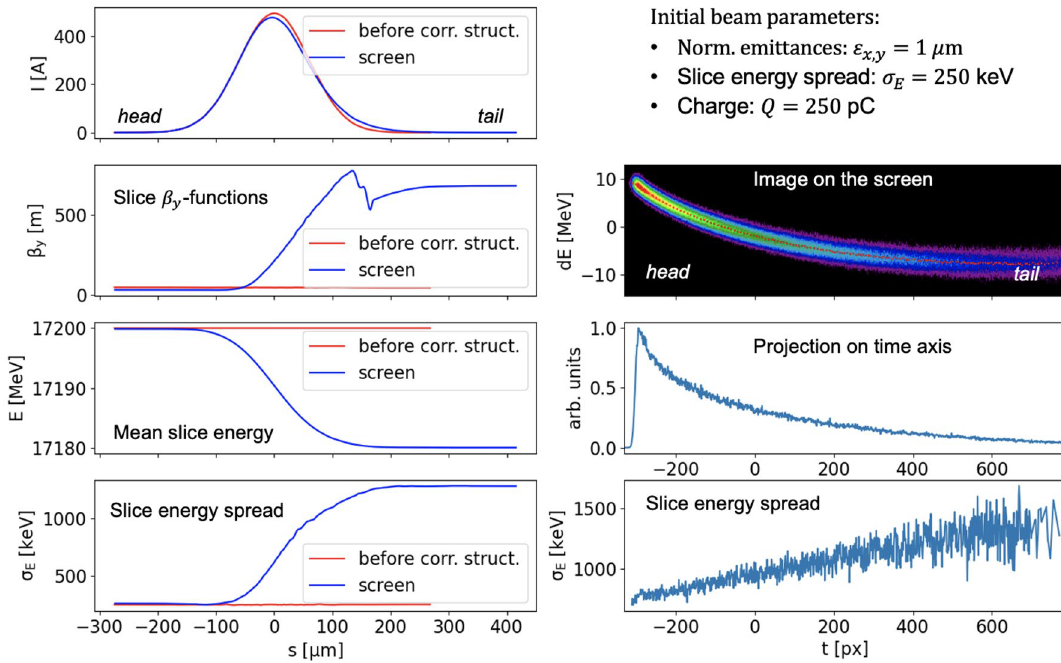
Figure 4. Modeling of the longitudinal phase space measurement with the corrugated structure. The initial beam parameters of an ideal Gaussian beam were chosen to be close to the estimated beam parameters during the quantum diffusion effect measurement. Left column shows the beam distribution before the corrugated structure and in the screen position, right column shows the image of the streaked beam and its analysis.